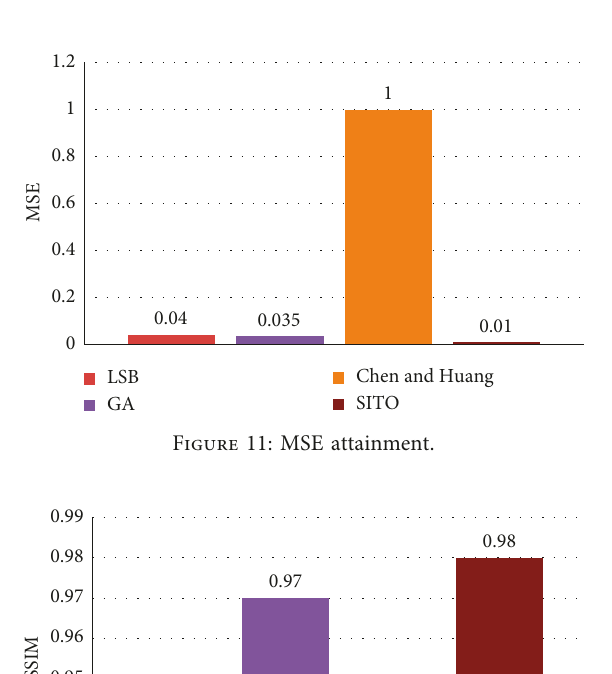
Figure 10: PSNR attainment.